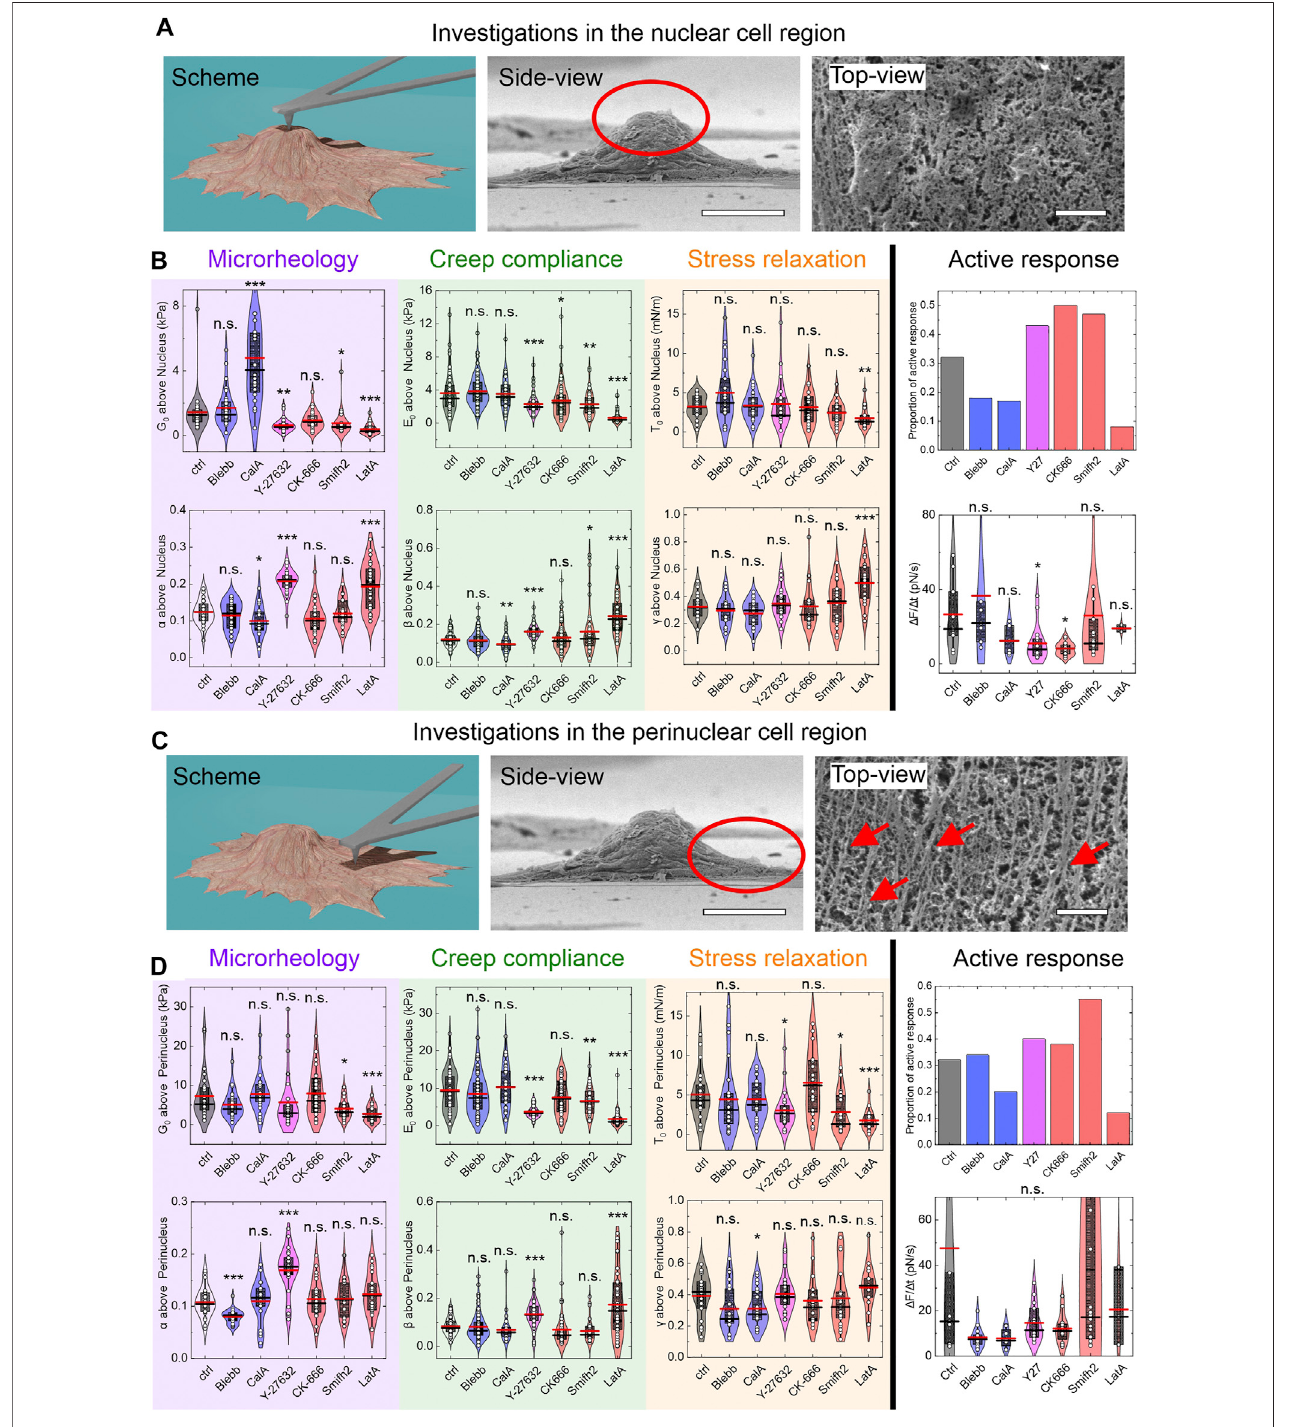
FIGURE 3 | Selected parameters obtained from rheological tests. (A) Position of the cantilever. (B) Data for control and applied drugs for G 0 and α from microrheology; E 0 and β fromthe creepcompliance;T 0 and γ fromstressrelaxation and theproportion ofcells actively responding during stressrelaxation; Δ F/ Δ tforthe activeresponse. (C,D) Sameasin (A) and (B) ,exceptforthecantileverpositionedattheperinucleus.Arrows,exemplaryactinbundles.n.s., p > 0.05;*, p < 0.05;**, p < 0.01;***, p < 0.001vs.untreatedcells(ctrl)(Student ’ st-tests).Scalebars (A,C) :20 µm(middleimages),1 µm(rightimages).CellnumbersNapplytoallparameters tested by the particular protocol (including Figure 4 and Supplementary Figure S3 ). Cell numbers N are in the following order: Ctrl, Blebb, CalA, Y-27632, CK-666, Smifh2,LatA.Microrheology (B) :N (cid:1) 28,28,20,29,29,24,26;Microrheology (D) :N (cid:1) 27,29,26,27,24,19,22;Creep compliance (B) :N (cid:1) 53,86,38,51,63,45,40; Creep compliance (D) : N (cid:1) 52, 73, 34, 49, 47, 31, 43; Stress relaxation (B) : N (cid:1) 26, 21, 28, 23, 19, 20, 17; Stress relaxation (D) : N (cid:1) 22, 22, 26, 24, 15, 21, 17; Active response (B) for Δ F/ Δ t:N (cid:1) 9,7,7,16,16,18,2;Activeresponse (D) for Δ F/ Δ t:N (cid:1) 9,13,8,15,12,20,3.Thetotalnumbersofcellsanalyzedforactiveresponseswere the same as for stress relaxation.